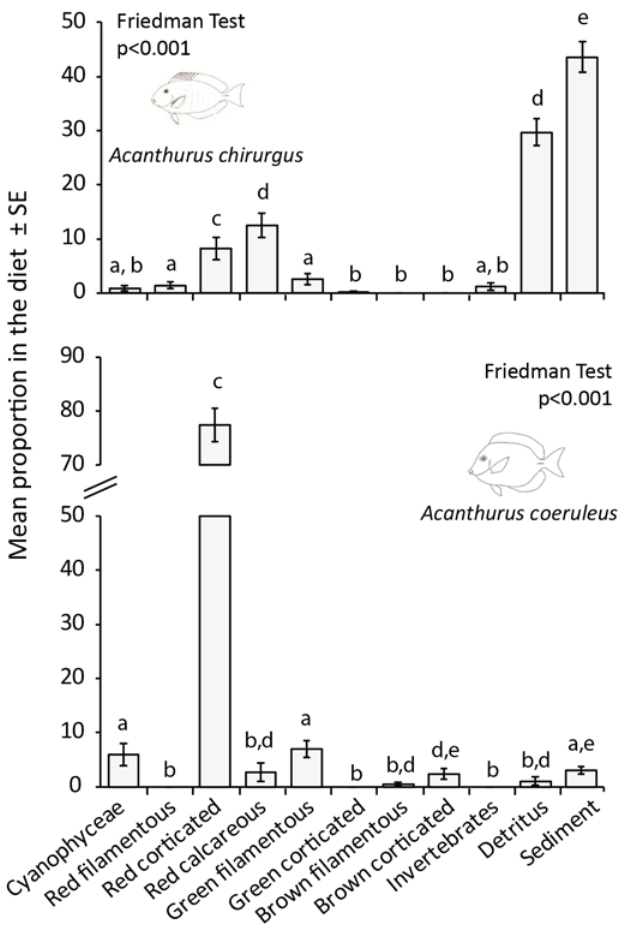
Fig 10. Diet of the two main roving herbivores at Rocas atoll: Acanthurus chirurgus and A . coeruleus . Letters above bars indicate post-hoc comparisons of the Friedman test. Error bars represent standard errors.